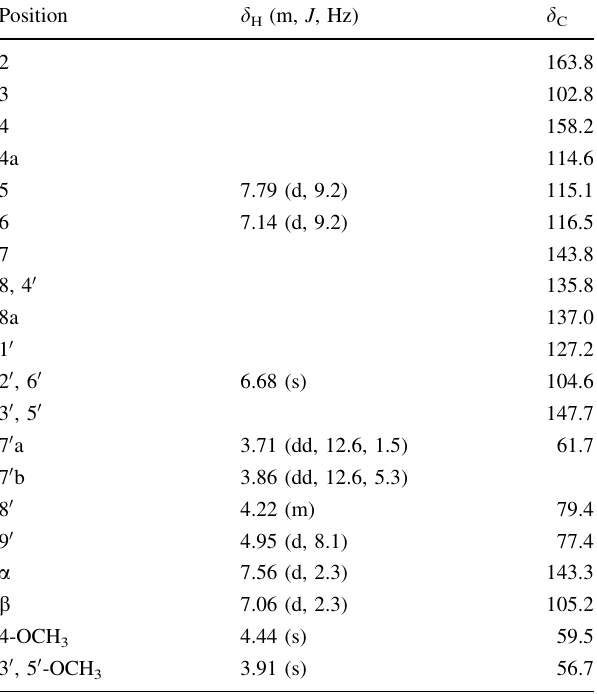
Table 1 1 H (600 MHz, d in ppm, J in Hz) and 13 C NMR (150 MHz, d in ppm) data of zanthonitidine A ( 1 ) in CDCl 3